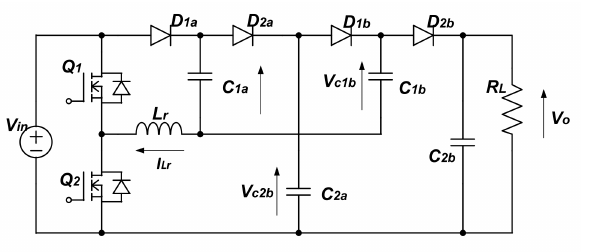
Figure 13. The conventional switched-capacitor resonant step-up converter (SWRSUC) used for comparison.